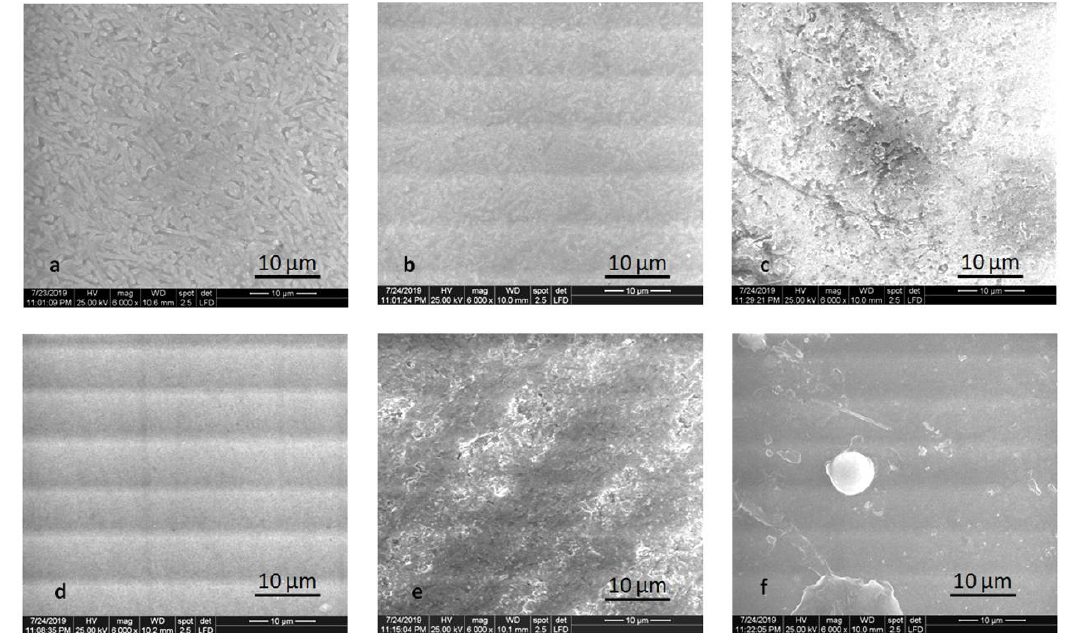
Figure 6. SEM images of the glazed samples: ( a ) LDS-P-G-HT, ( b ) LDS-P-G-MT, ( c ) LDS-M-G-MT, ( d ) ZLS-P-G-HT, ( e ) ZLS-P-G-MT, and ( f ) ZLS-M-G-MT.